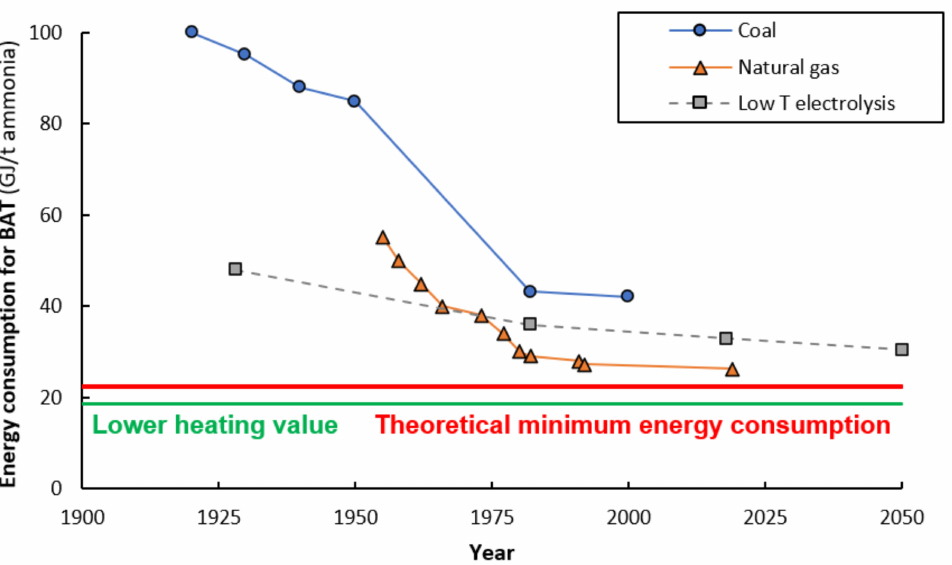
Figure 10. Technology-based development for coal-based ammonia synthesis, electrolysis-based ammonia synthesis, and natural gas-based ammonia synthesis. Partially adapted from references [5,7]. BAT: best available